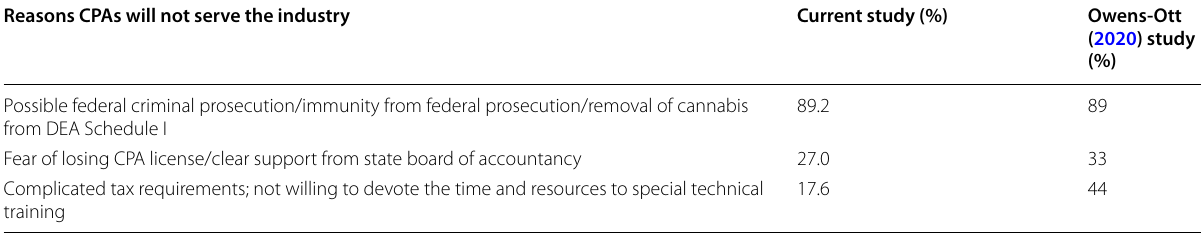
Table 7 Comparison of reasons CPAs will not serve the industry from this study and the 2020 Owens‑Ott study Reasons CPAs will not serve the industry